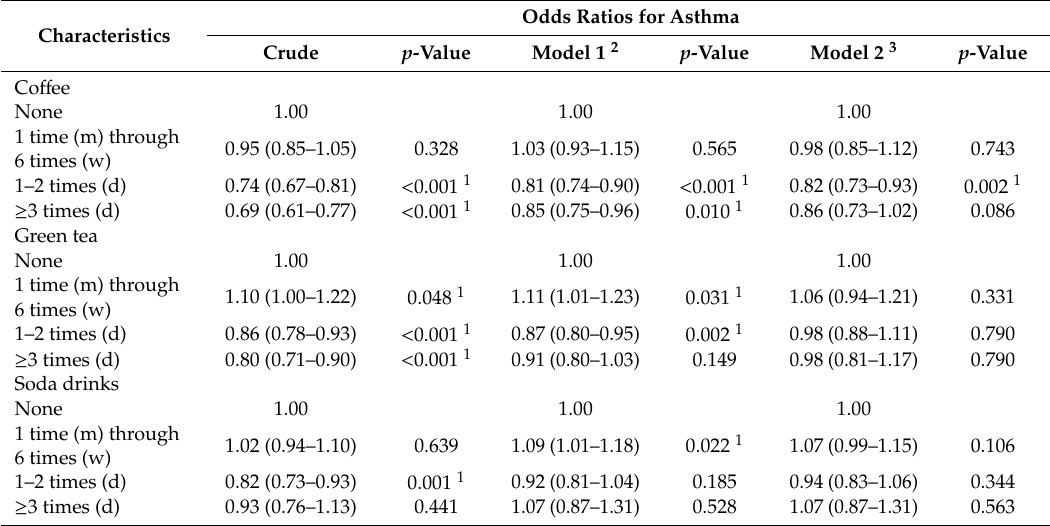
Table 2. Crude and adjusted odds ratios (95% confidence interval) for asthma by co ff ee, green tea, and soda drink intake (frequency).